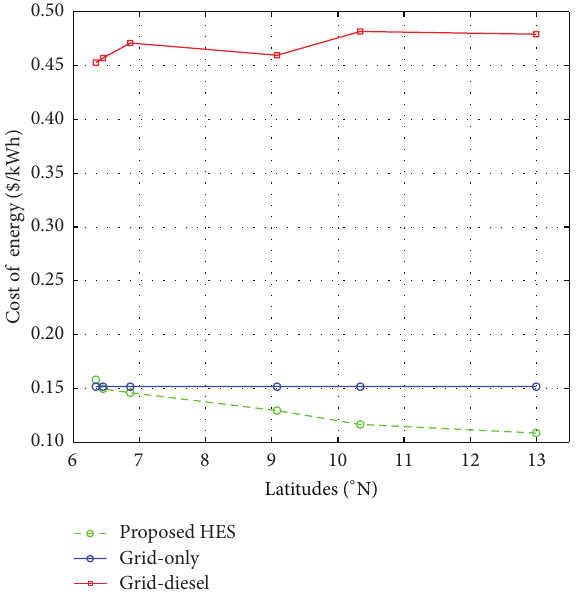
Figure 10: Variation of the energy throughput of the proposed and existing energy systems with geographical locations.